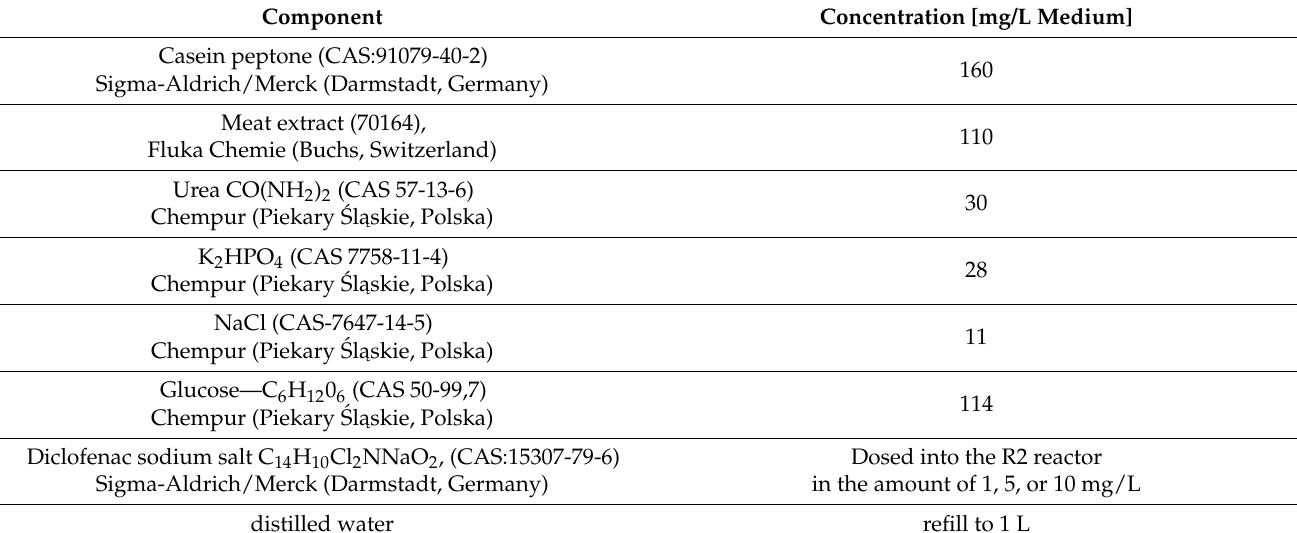
Table 2. The composition of the medium selected and used in the